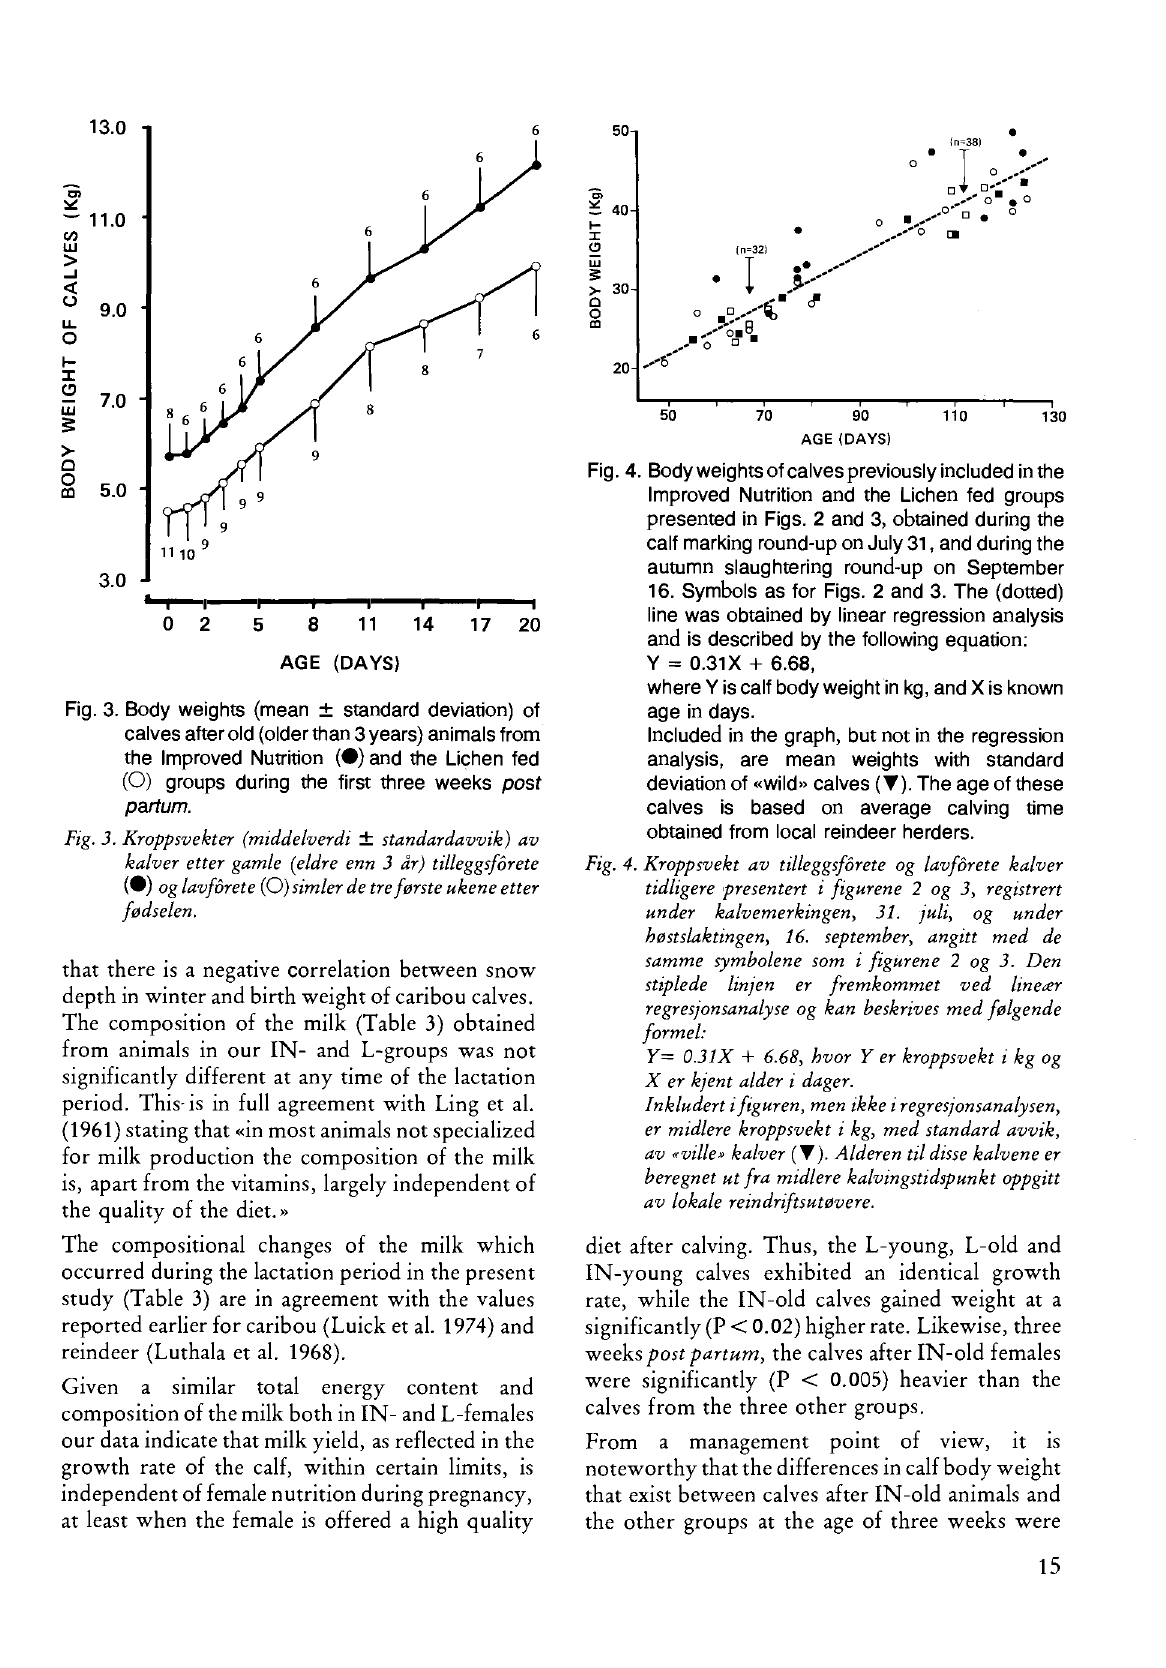
Fig. 4. Body weights of calves previously included in the Improved Nutrition and the Lichen fed groups presented in Figs. 2 and 3, obtained during the calf marking round-up on July 31, and during the autumn slaughtering round-up on September 16. Symbols as for Figs. 2 and 3. The (dotted) line was obtained by linear regression analysis and is described by the following equation: Y = 0.31 X + 6.68, where Y is calf body weight in kg, and X is known age in days. Included in the graph, but not in the regression analysis, are mean weights with standard deviation of «wild» calves (T). The age of these calves is based on average calving time obtained from local reindeer herders. Fig. 4. Kroppsvekt av tilleggsforete og lavforete kalver tidligere presentert i figurene 2 og 3, registrert under kalvemerkingen, 31. juli, og under høstslaktingen, 16. september, angitt med de samme symbolene som i figurene 2 og 3. Den stiplede linjen er fremkommet ved lineær regresjonsanalyse og kan beskrives med følgende formel: Y= 0.3IX + 6.68, hvor Y er kroppsvekt i kg og X er kjent alder i dager. Inkludert i figuren, men ikke i regresjonsanalysen, er midlere kroppsvekt i kg, med standard avvik, av «ville» kalver (W). Alderen til disse kalvene er beregnet utfra midlere kalvingstidspunkt oppgitt av lokale